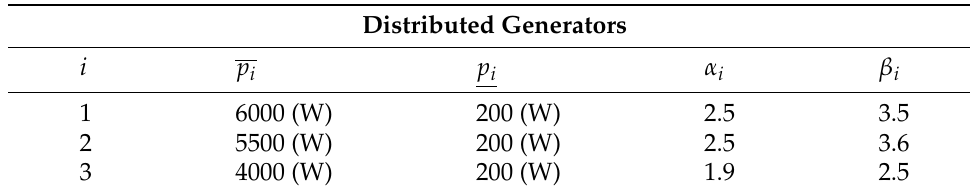
Figure 2. Distribution network with DERs adapted from an IEEE 9-bus test feeder. Table 1. System parameters’ simulation.